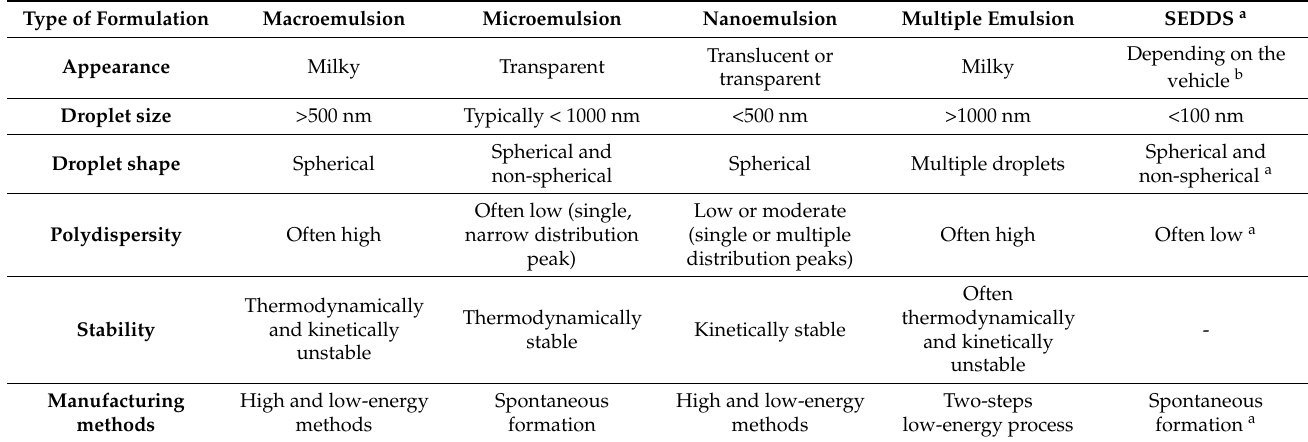
Table 2. Classification and characteristic of the emulsion-based dosage form [58–72].